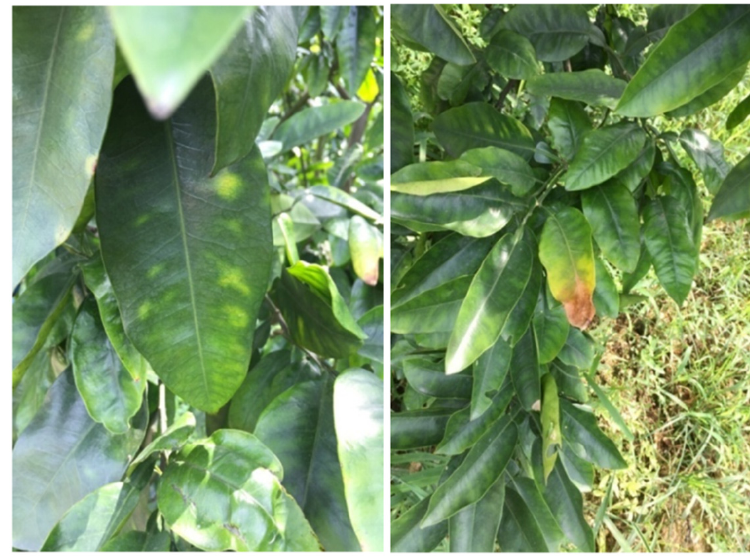
Figure 2. Leaf symptoms of B toxicity on pummelo ( C. grandis ) in field.